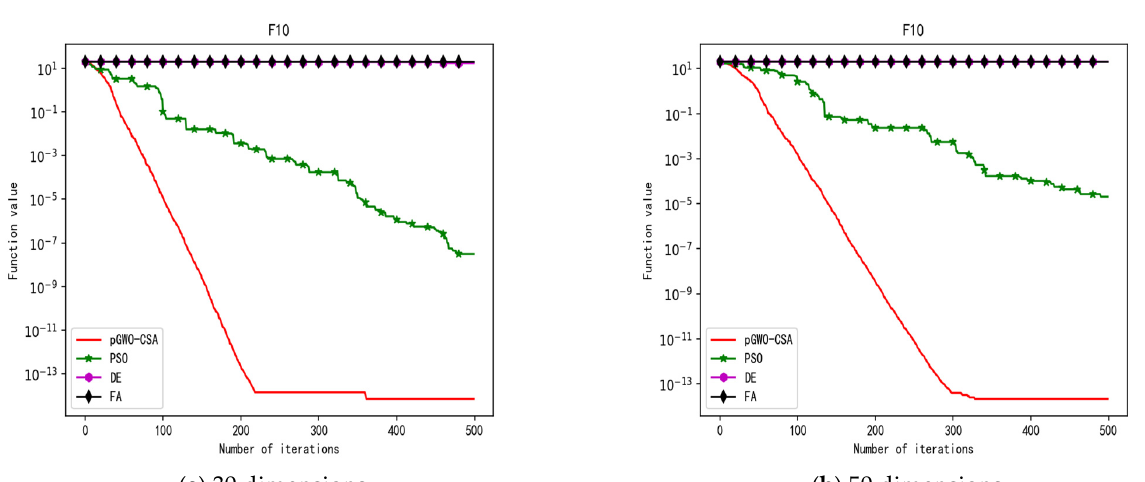
Figure 14. Convergence curve of test function F10.